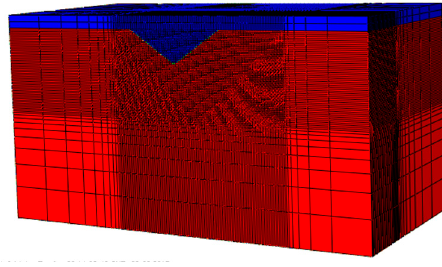
Figure 5. The mesh of soil.